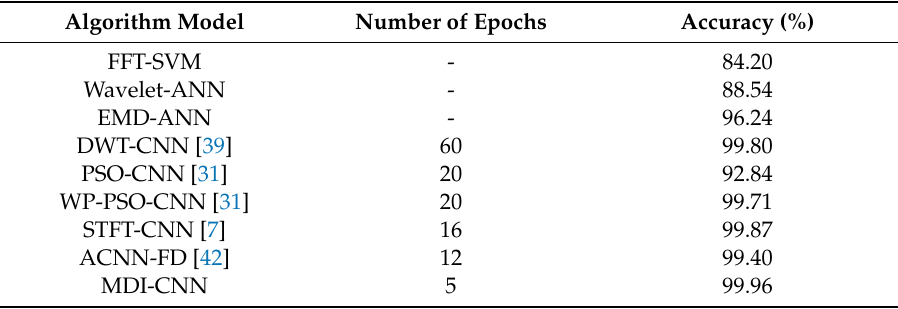
Table 4. Classification accuracy of di ff erent